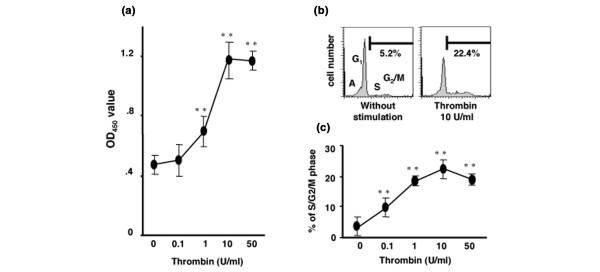
Thrombin induces synovial proliferation and progression to S phase in RA SFs. Cells were cultured for 48 hours in DMEM containing 1% FCS and then stimulated with the indicated amount of thrombin. For the proliferation assay, at 24 hours after thrombin stimulation, cells were stained with TetraColor One including tetrazolium and electron-carrier mixture for detecting cell proliferation. The optical density (OD) was measured by ELISA plate reader at 450 nm. For analysis of the cell cycle, at 24 hours after thrombin stimulation, cells were collected, washed with PBS, and fixed in 70% ethanol for 2 hours at 4°C. After treatment of cells with 10 μg/ml ribonuclease for 15 min at 37°C, fixed cells were stained with 50 μg/ml propidium iodide for 2 min. The DNA content was subsequently measured by FACScan fluorescence-activated cell sorter. (a) Dose-dependent proliferation of synovial fibroblasts (SFs) from rheumatoid arthritis (RA) patients. The OD was measured by ELISA plate reader at 450 nm. (b) Histogram representing the cell cycle in RA SFs, as detected by FACScan. (c) Dose-dependent S-phase progression of the cell cycle in RA SFs. Numbers represent the percentage of cells exhibiting mean channel fluorescence (FL2-H) in the S/G2/M phase of the cell. Data are expressed as mean ± standard deviation for five experiments, using five independent donors. **P < 0.01 in comparison with the value found without thrombin stimulation.